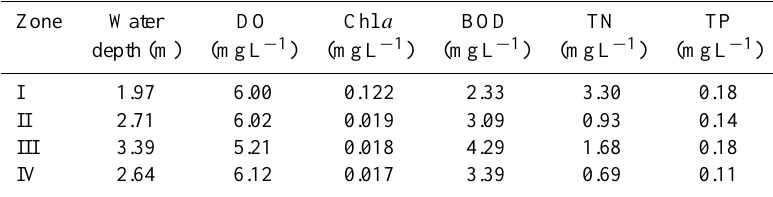
Table 7. Average water depth and water quality for different water area zones.